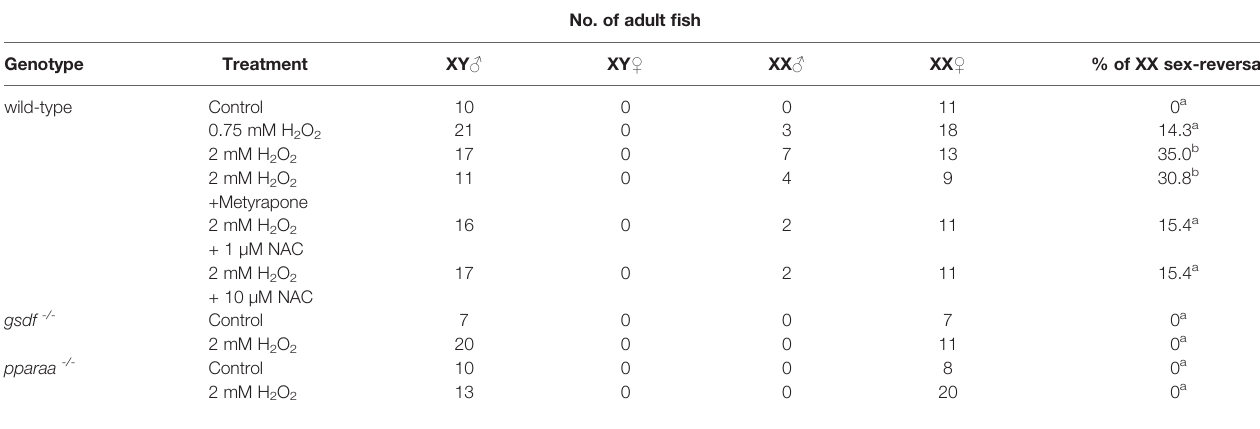
TABLE 1 | Sex ratios in adult medaka. a and b: signi fi cant difference (p < 0.05).